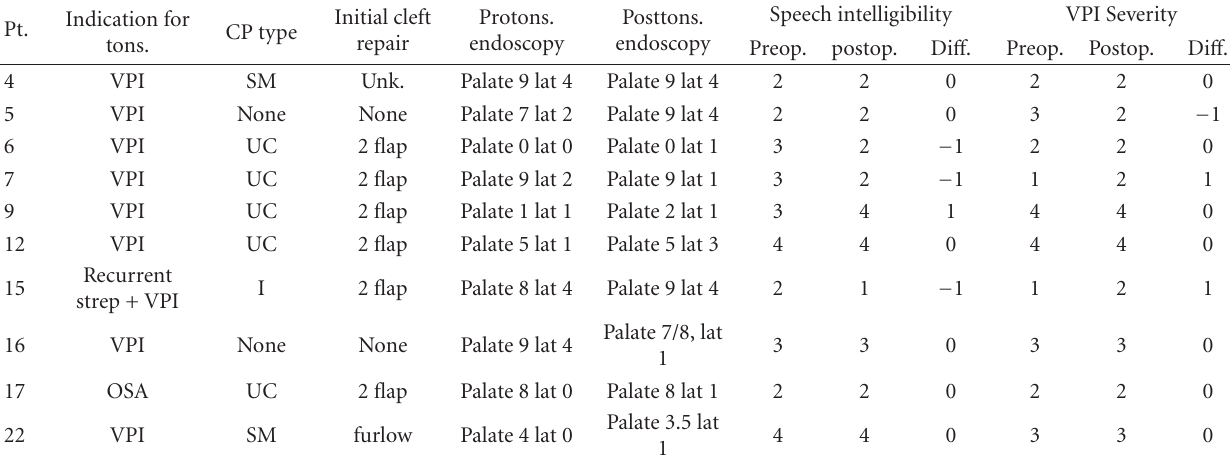
Table 2: Nasal endoscopy scores.